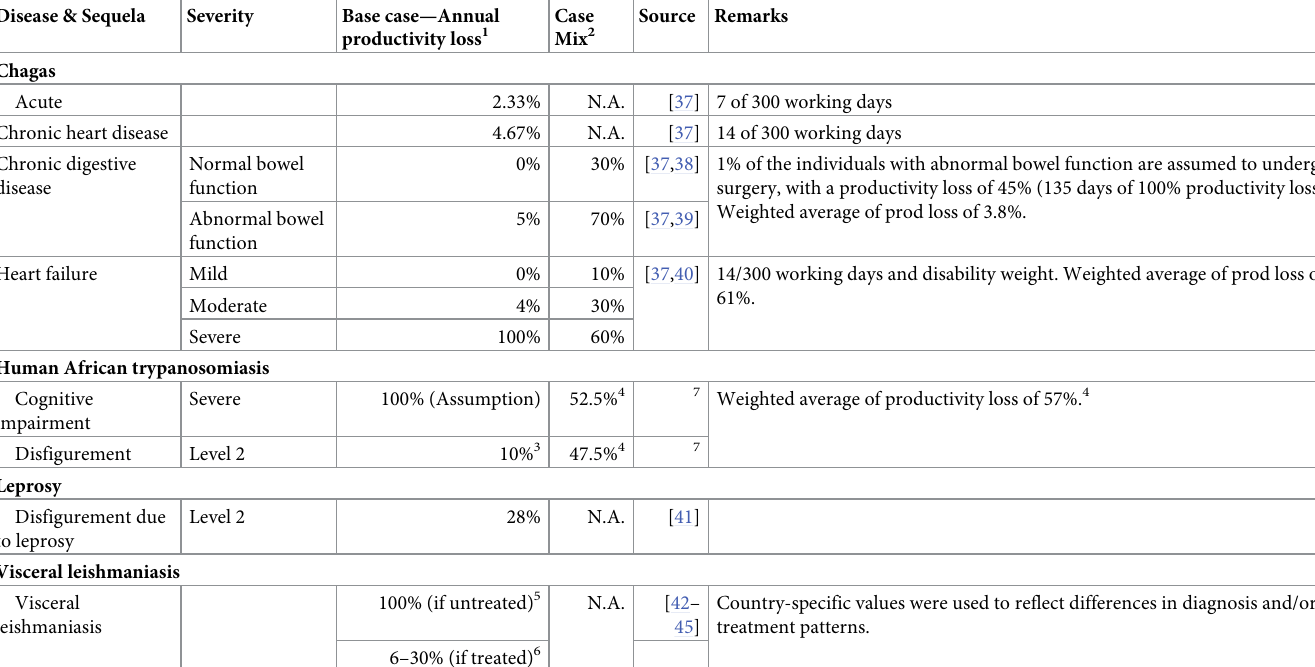
Table 1. Annual percentages of productivity loss used in the calculations of economic